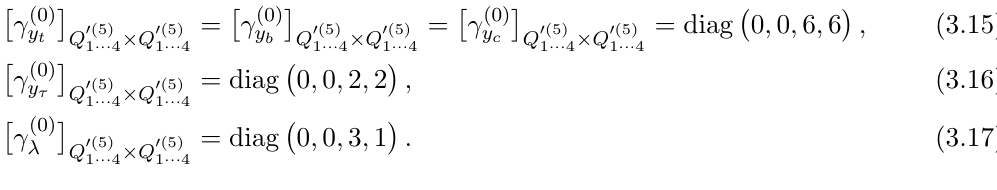
Figure 5 . The renormalization of the Q 0 (5) of each class of diagrams